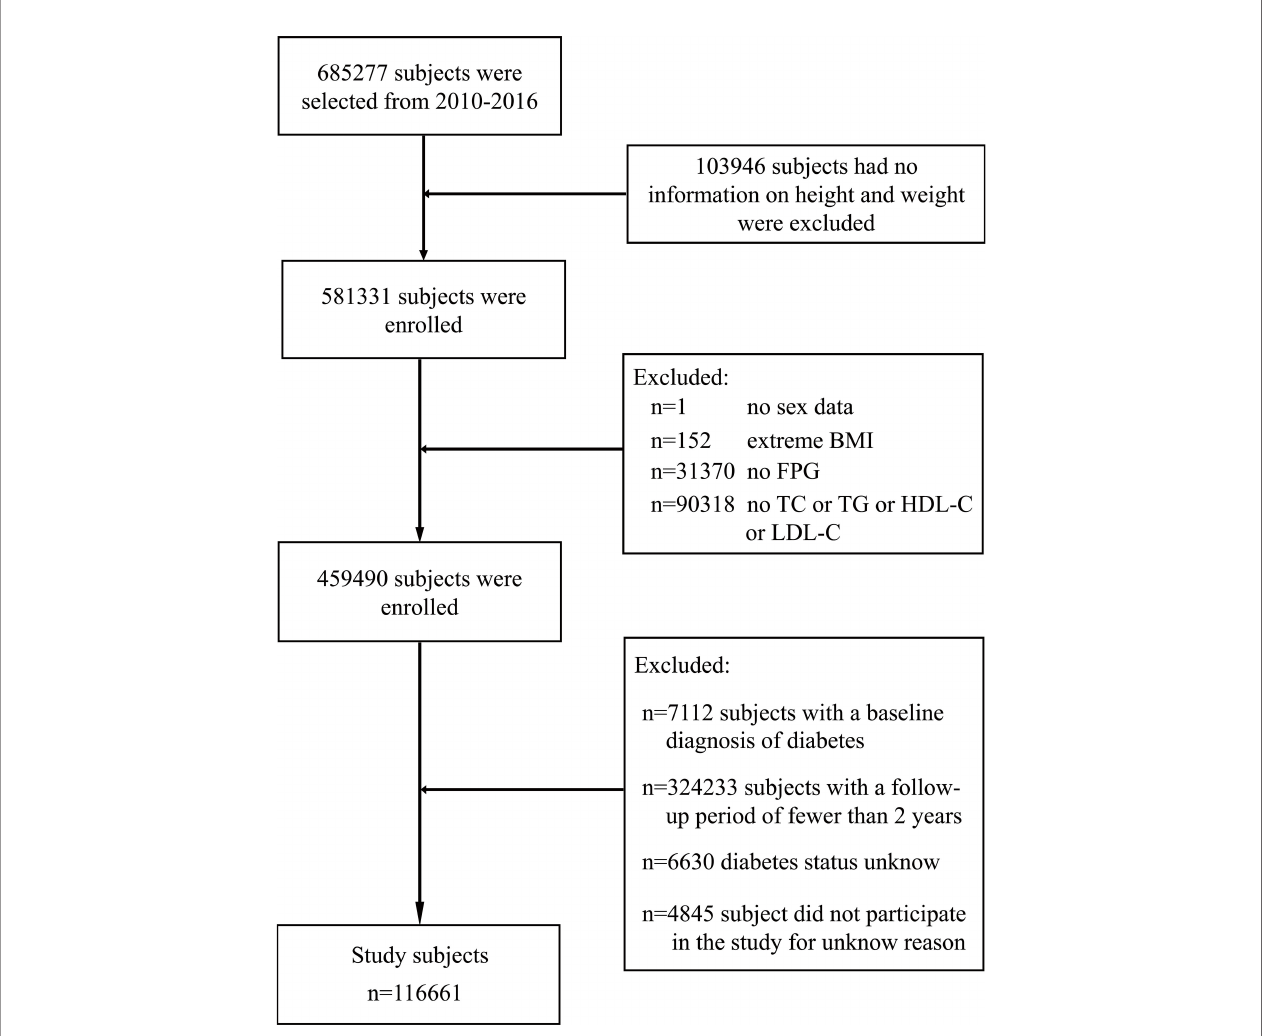
FIGURE 1 | Flow diagram of subjects included in the cohort